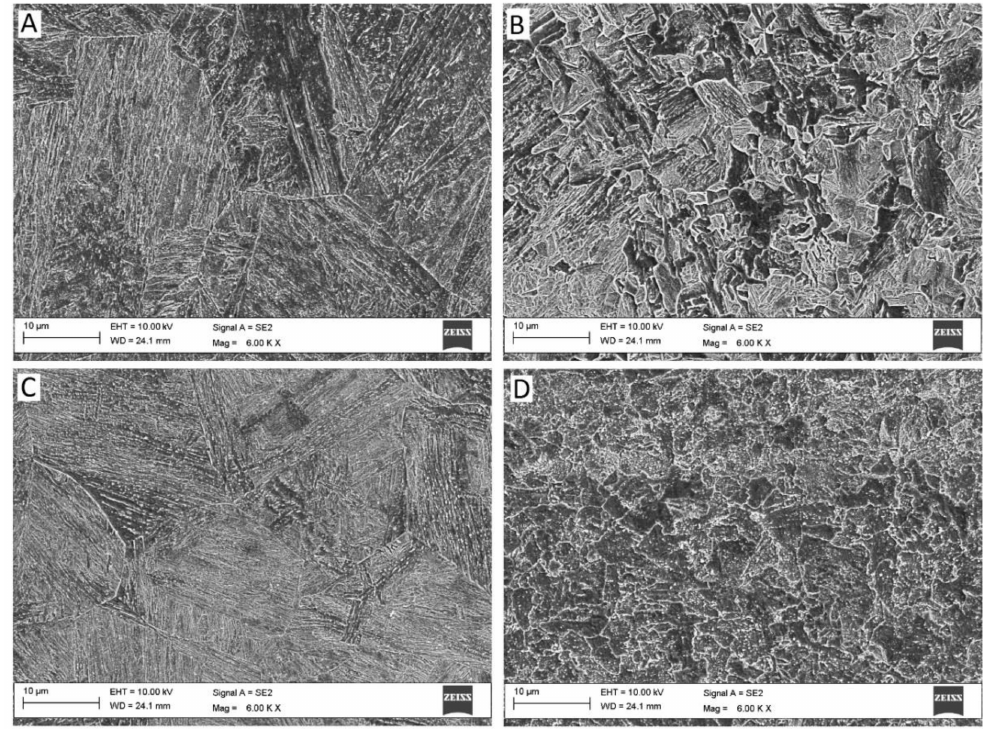
Figure 18. SEM images from low heat input weld (t 8/5 = 5 s) HAZ for steel S690QL. ( A – D ) are locations established in Figure